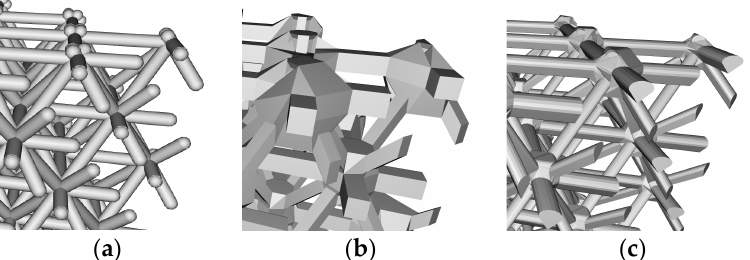
Figure 12. Different cross-sections for the beams that constitute the lattice: ( a ) circular section, ( b ) square section and ( c ) teardrop shape to aid in self-supporting overhangs (screenshots from nTopology’s Element software) [21].